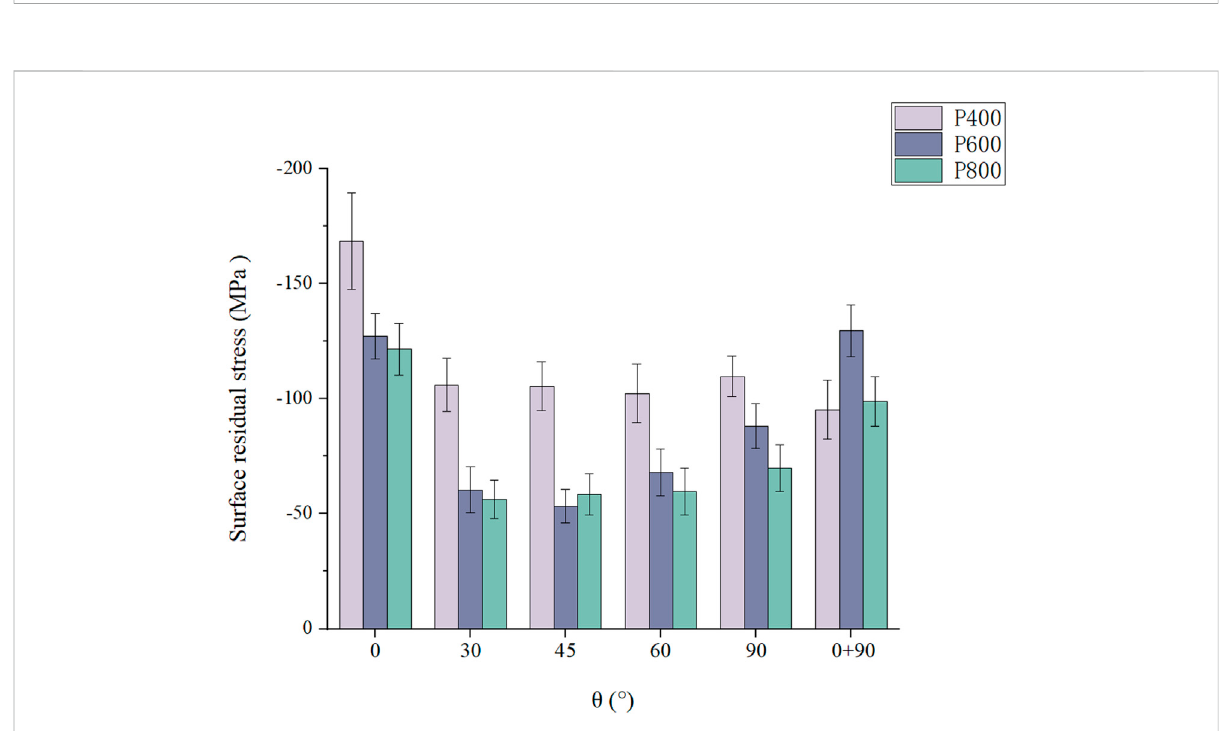
FIGURE 8 Residual stress results for different trajectory